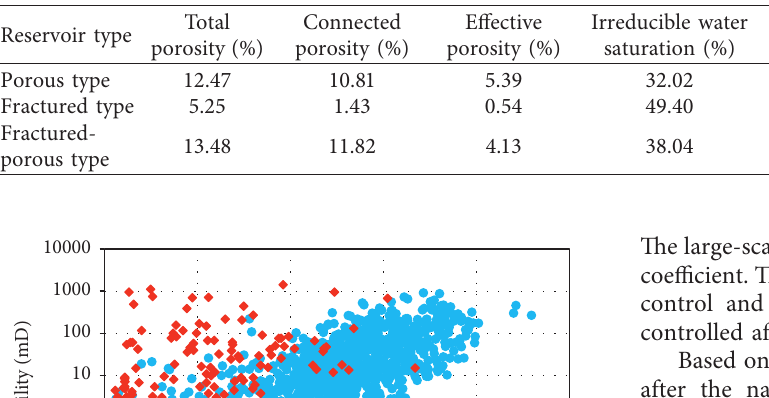
Porous type Fractured-porous type Porous-cavernous type Figure 8: Digital core simulation of movable remaining oil distribution in different types of reservoirs. (a) Porous type. (b) Fractured- porous type. (c) Porous-cavernous type. Table 3: Porosity and remaining oil saturation of different types of reservoirs.